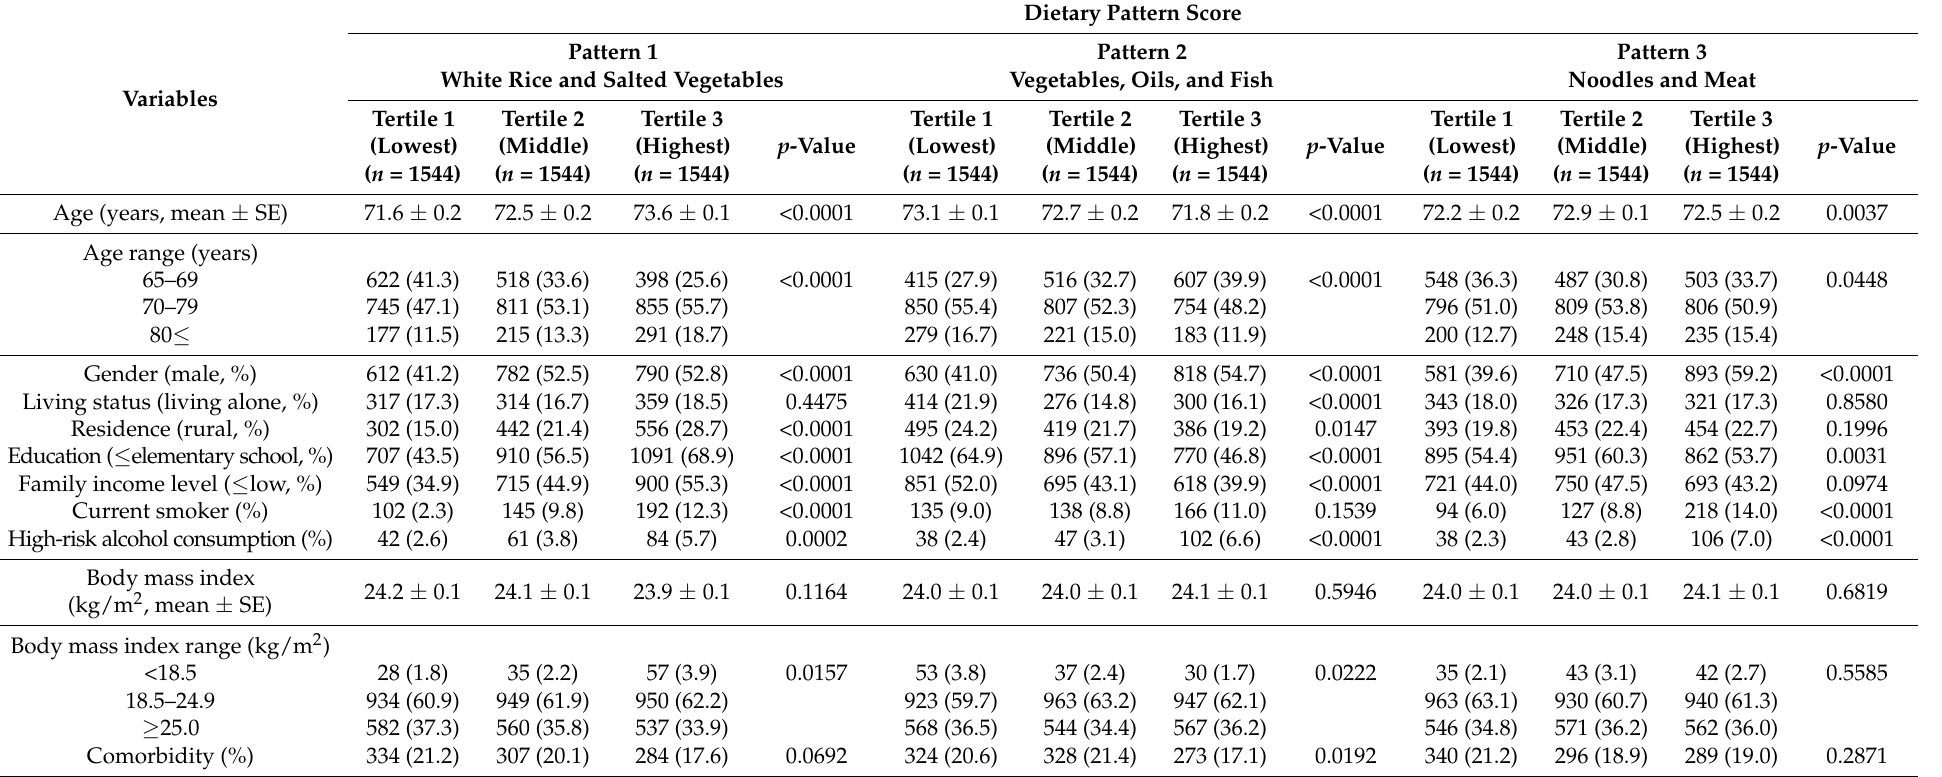
Table 3. General characteristics across tertiles of dietary pattern